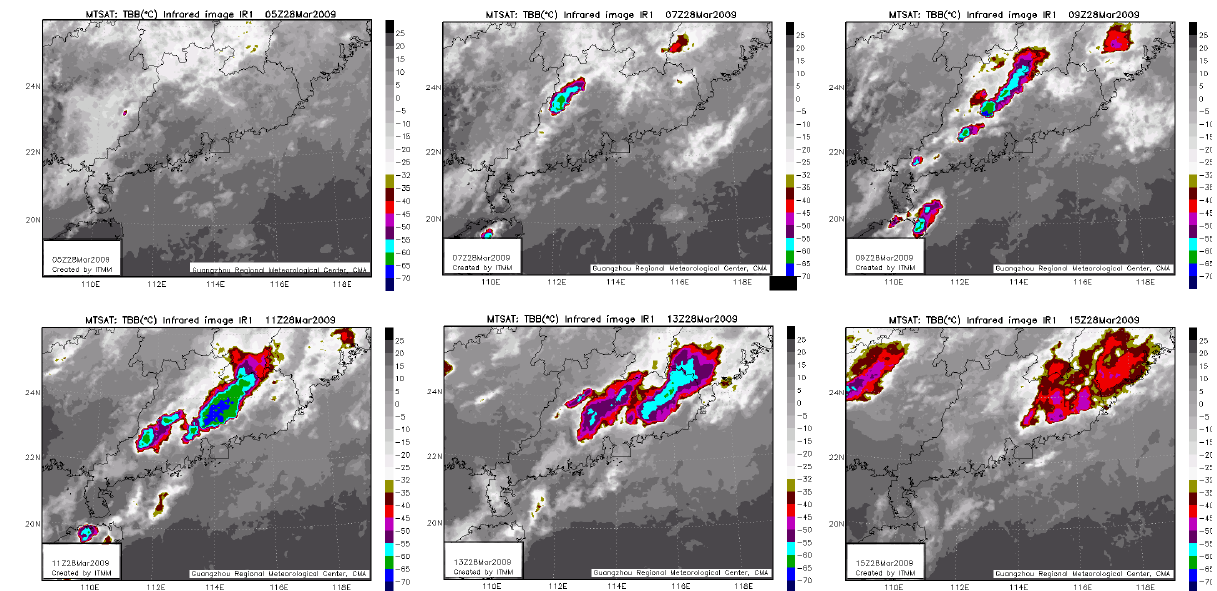
Fig. 3. Infrared images of clouds from the MTSAT satellite, showing the development of a frontal system in term of the brightness temperature variance of the cloud top.